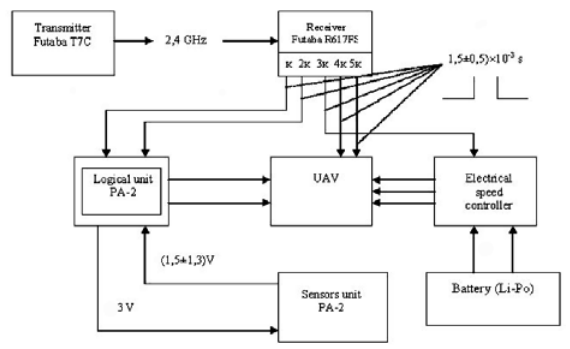
Fig. 13. Control system of UAV A Futaba T7C 7-channel transmitter unit was